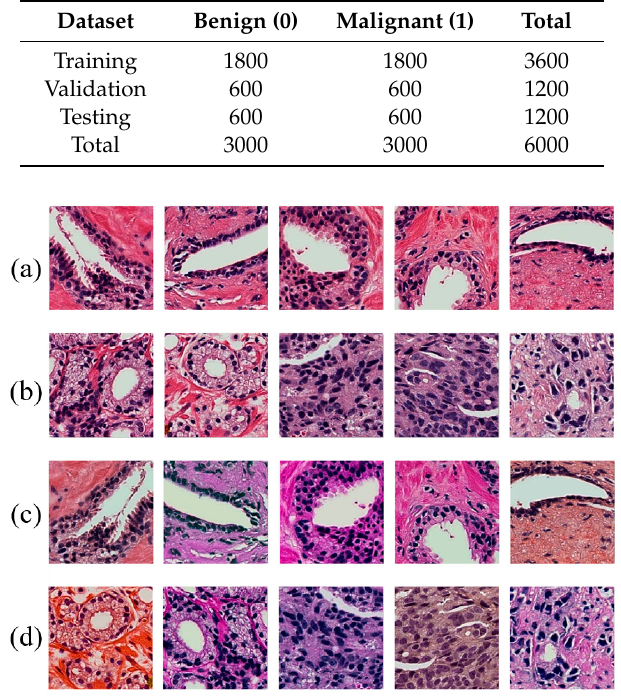
Figure 5. Randomly selected samples from the training dataset demonstrating data augmentation. ( a , b ) Images of benign and malignant tissues, respectively, before the transformation. ( c , d ) Transformed images from ( a , b ), respectively, after data augmentation.